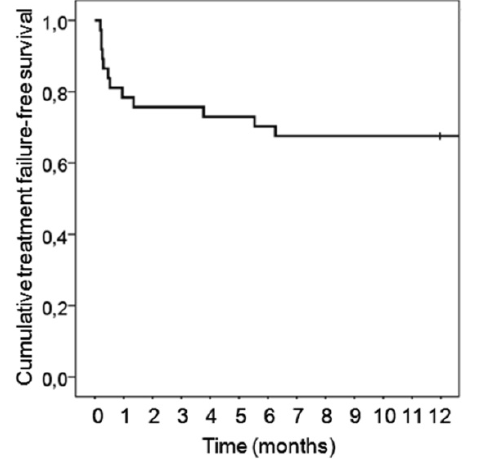
Figure 2 : Treatment failure-free survival